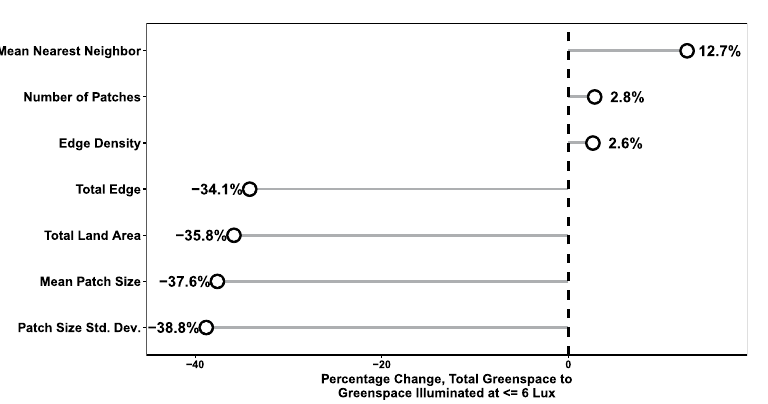
Figure 5. Chicago’s greenspace illuminated at over 6 lux is substantially different in extent and spatial structure from its total greenspace. This graphic presents percent changes in a range of landscape metrics between the entire greenspace and greenspaces estimated to be lit at above 6 lux. The metrics are based on patches, which are blocks of continuous greenspace cover. Over one-third of the greenspace areas in Chicago are exposed to illumination levels > 6 lux, and light-exposed areas split large greenspaces patches, resulting in substantial reductions in the mean patch size. At the same time, small greenspace patches tend to be completely exposed to behaviorally relevant artificial light levels, resulting in only small increases in the total number of patches. The splitting of the largest and elimination of the smallest patches further results in substantial declines in the standard deviation of patch size, a decline in the total edge of all patches, and a moderate increase in the mean distance between patches and their nearest neighboring